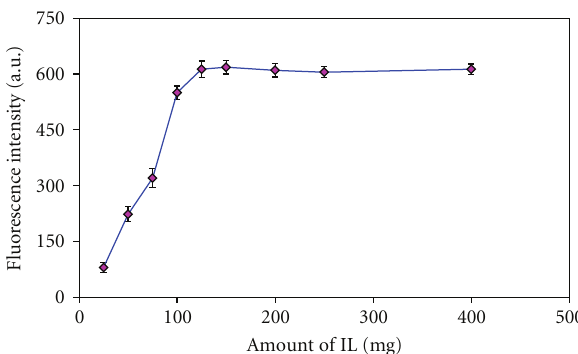
Figure 3: Influence of NaPF 6 on the analytical signals obtained for terazosin. Experimental conditions: terazosin concentration 75 μ g L − 1 ; pH 10; [Hpy][PF 6 ] 150mg.